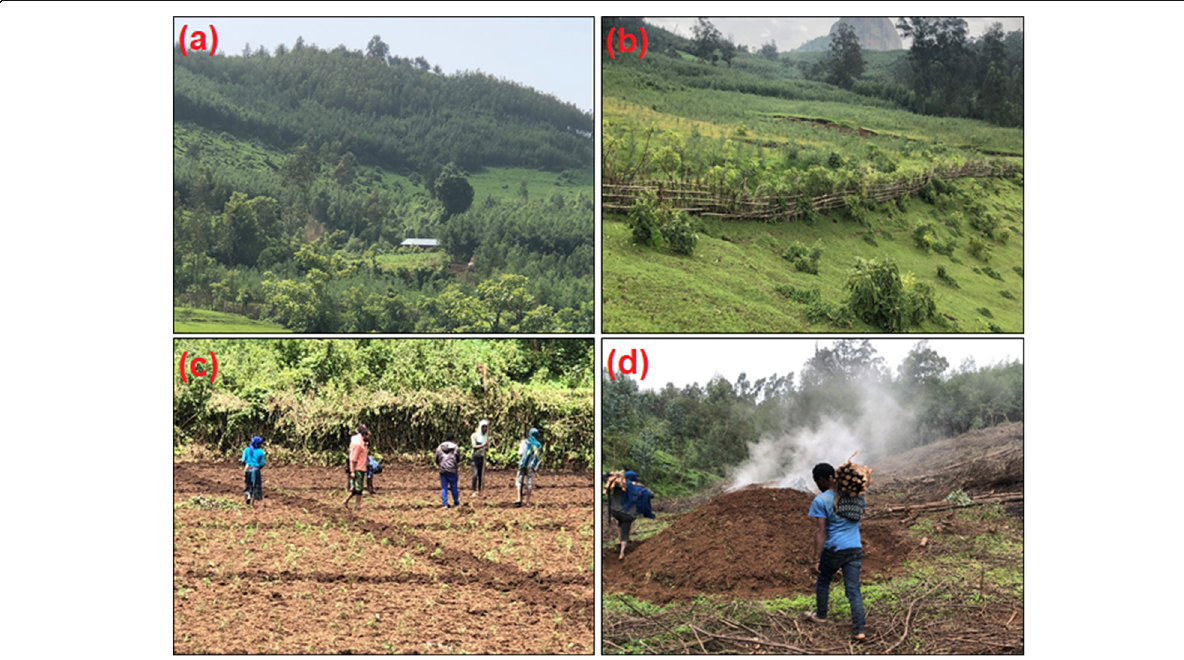
Fig. 6 a Example of an Acacia decurrens plantation, b a plantation on grazing land, c planting on cultivated land, and d the traditional process of producing fuel wood (charcoal) from A . decurrens trees in Guder watershed,